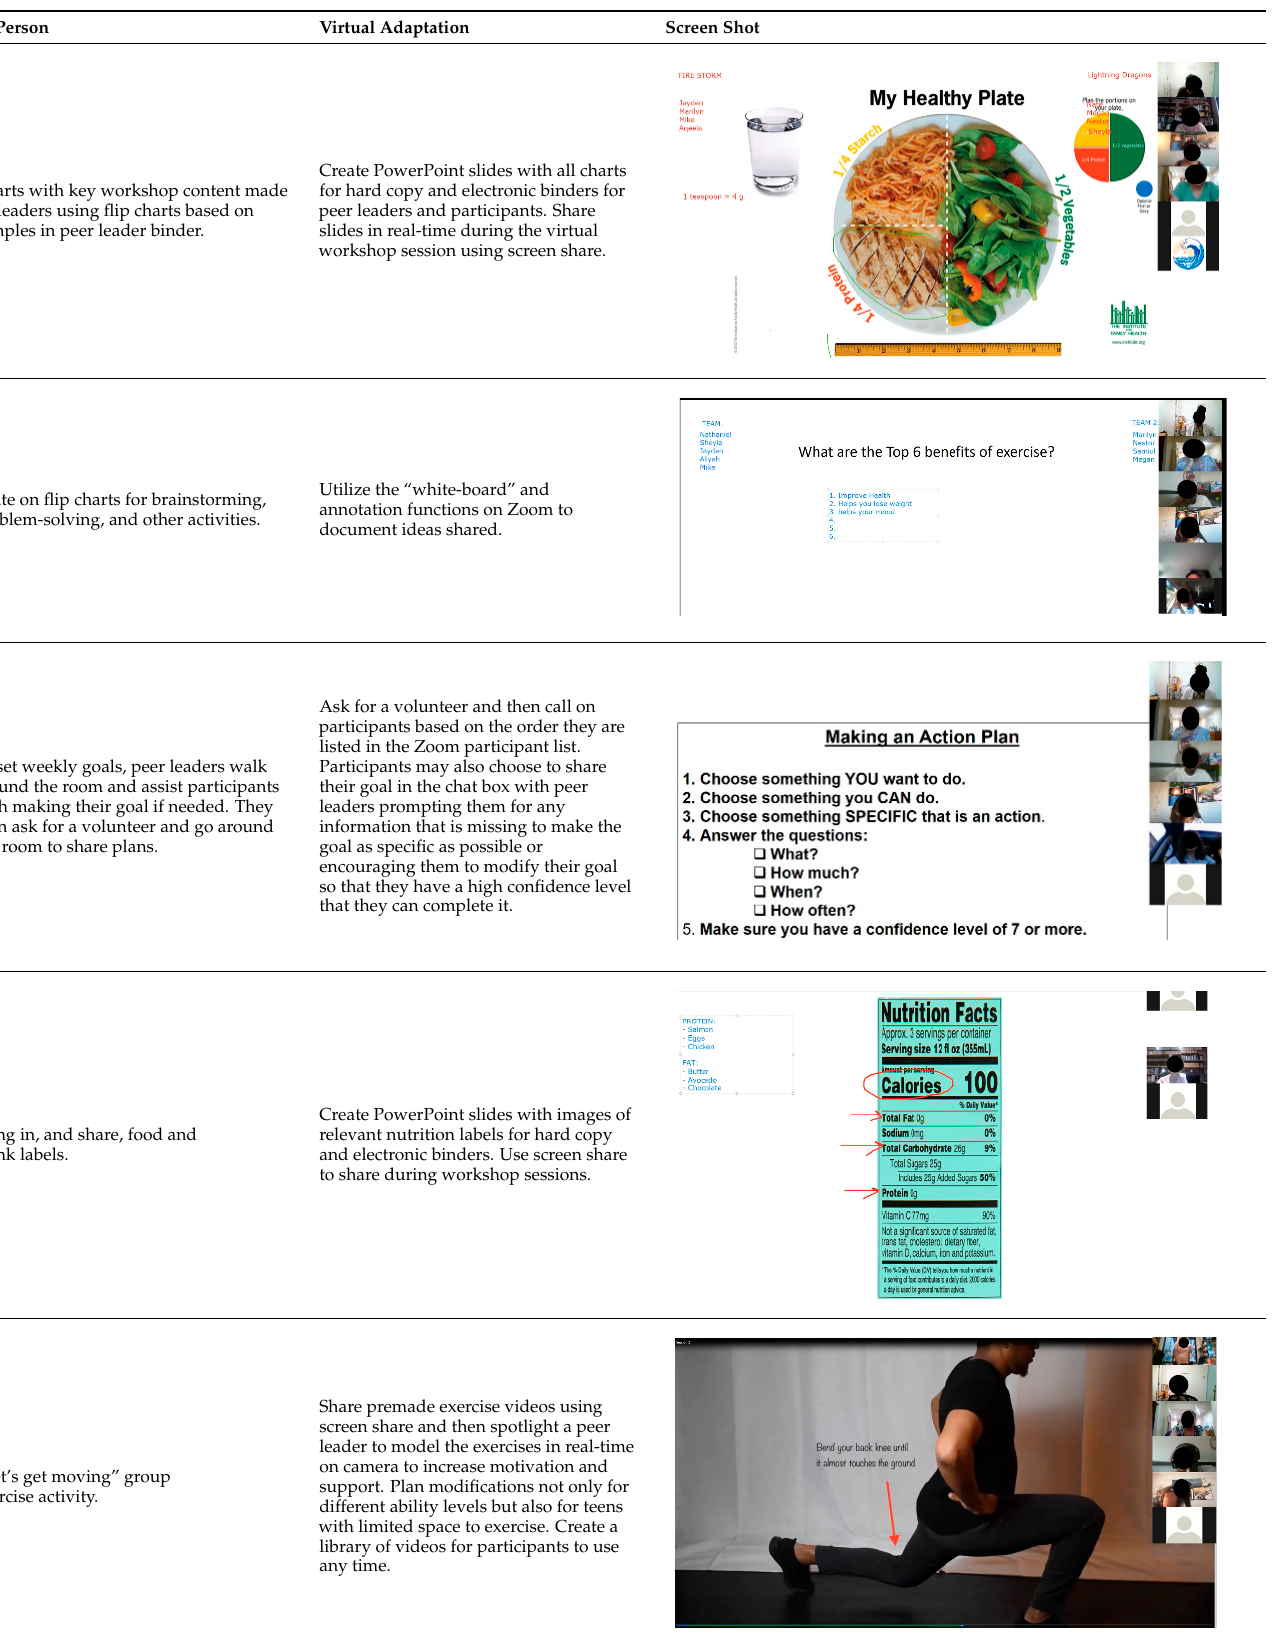
Table 1. Adaptations for virtual program delivery.